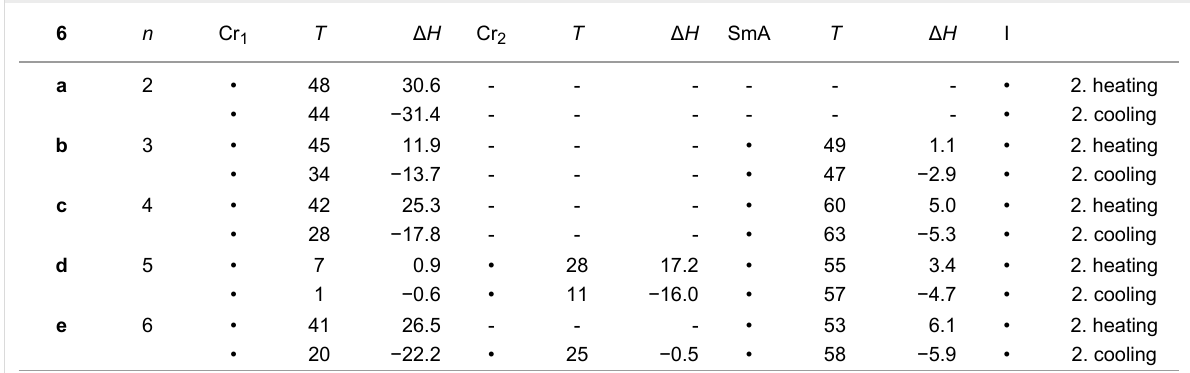
Table 3: Phase transition temperatures [°C] and enthalpies [kJ/mol] of compounds 6 . a